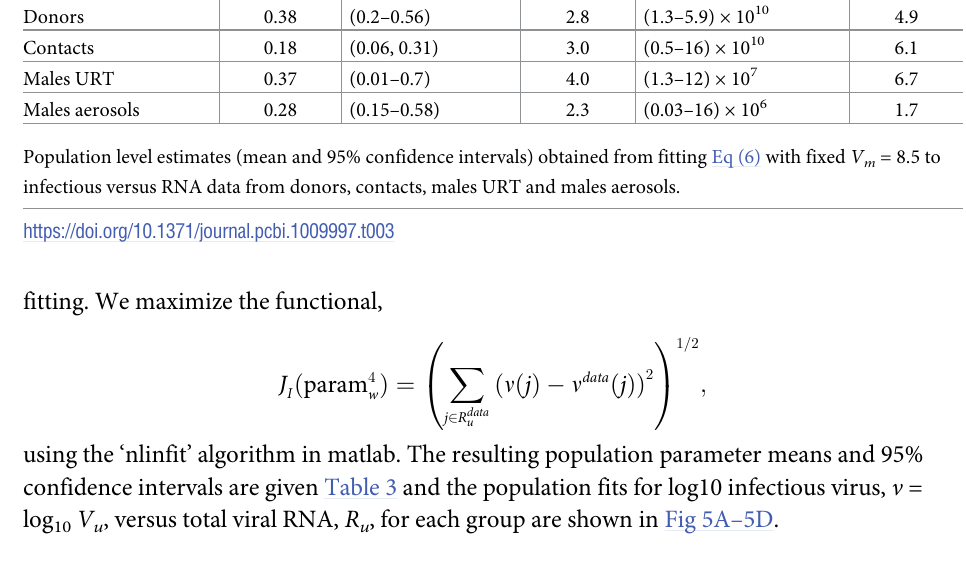
) as a function of total RNA R u